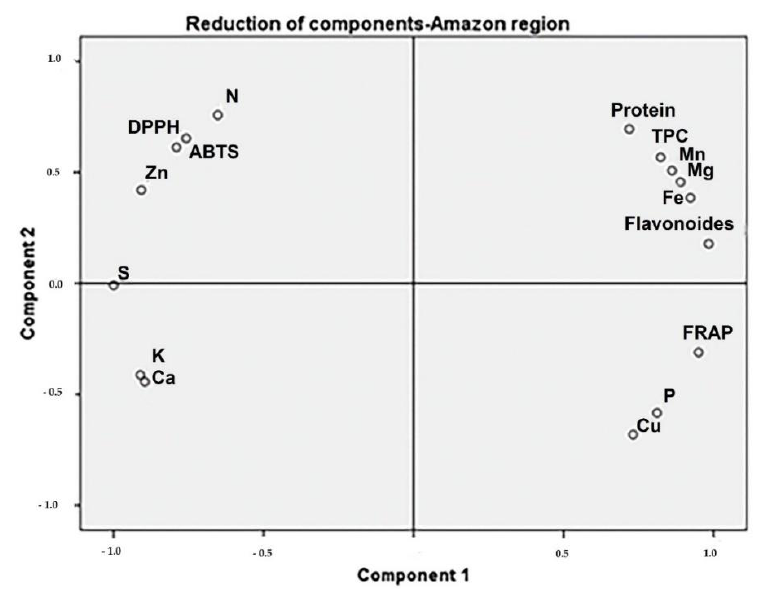
Figure 4. The phytochemical and biological composition of M. oleifera from the Amazonian region. Loading plot of PC1 versus PC2, showing the influence of Mn, MG, Fe, TFC, and TPC. Legend: TPC— total phenolic content, TFC—total flavonoid content, FRAP—ferric-reducing antioxidant power, ABTS–free radical scavenging activity, DPPH—free-radical-scavenging ability by the use of a stable DPPH • radical.